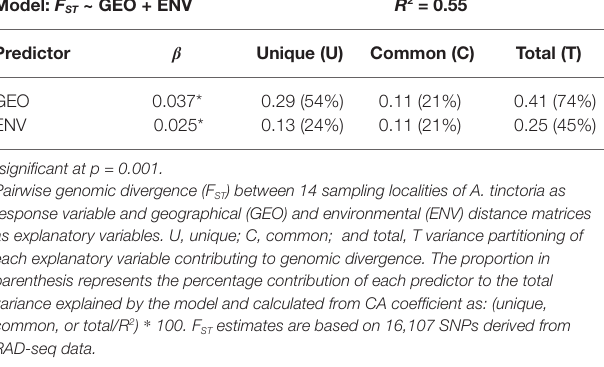
TABLE 3 | Summary of multiple matrix regression with randomization (MMRR) and commonality analysis (CA). Model: F ST ~ GEO +